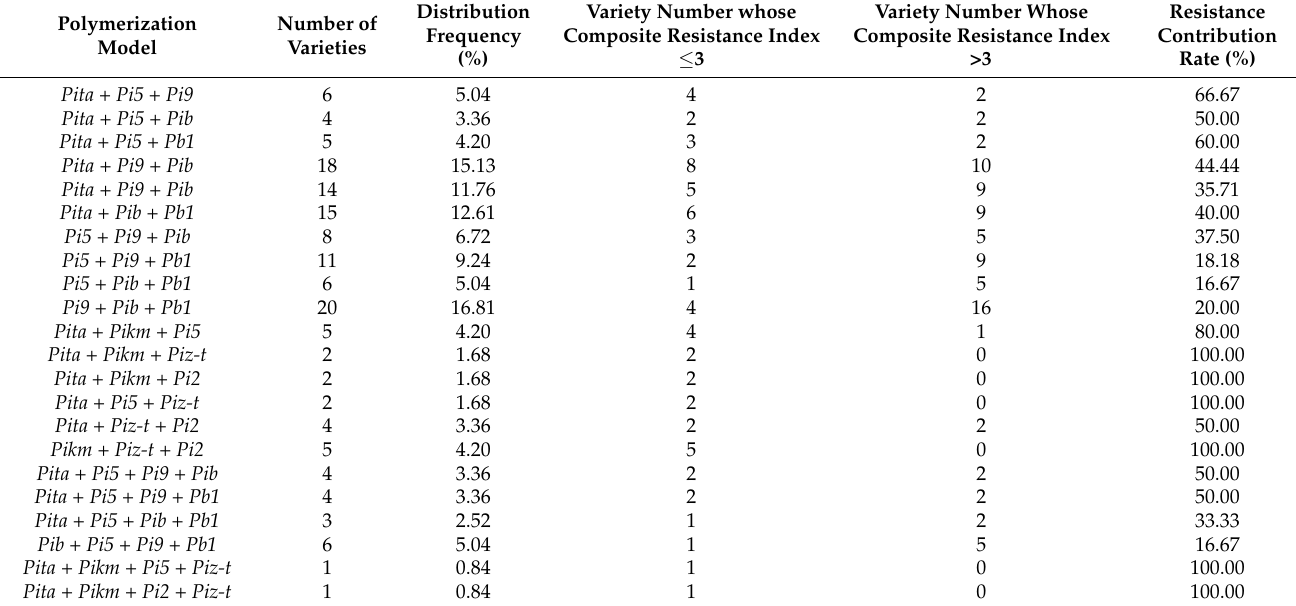
Table 5. The distribution frequency and resistance contribution rate of different gene